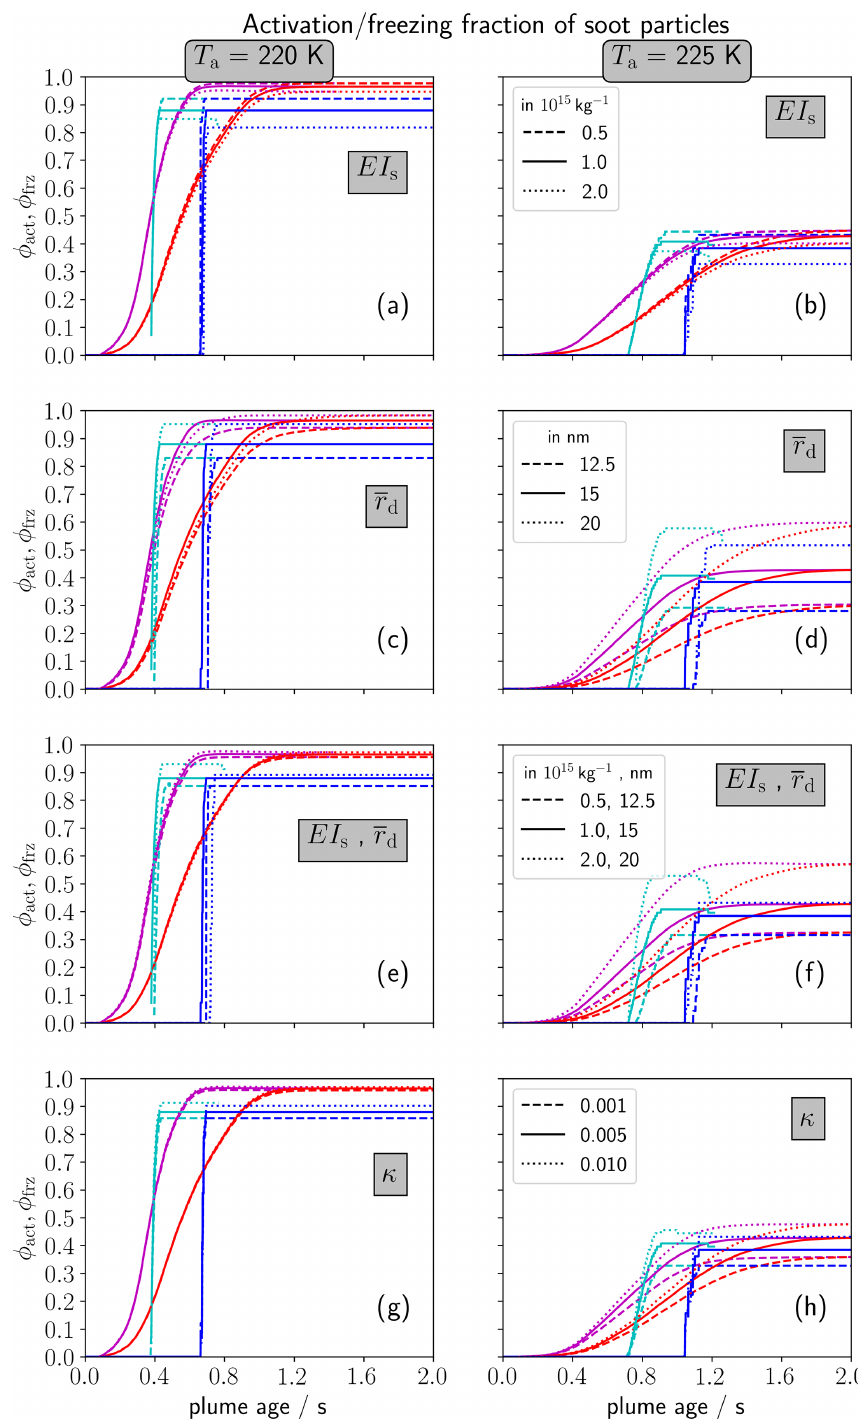
Figure 3. Temporal evolution of the fraction of soot particles activating into water droplets φ act (cyan and magenta) and forming ice crystals φ frz (blue and red) for a variation of the soot number emission index EI s (a, b) , geometric-mean dry core radius r d (c, d) , a combined variation of EI s and r d (e, f) and a variation of the hygroscopicity parameter κ (g, h) . The left column (a, c, e, g) shows the baseline ( T a =220K) and the right column (b, d, f, h) a near-threshold case ( T a =225K). The magenta and red lines show the ensemble mean and the cyan and blue lines the average traj results. The different line types (see legends on the right column) represent the according soot parameter variations